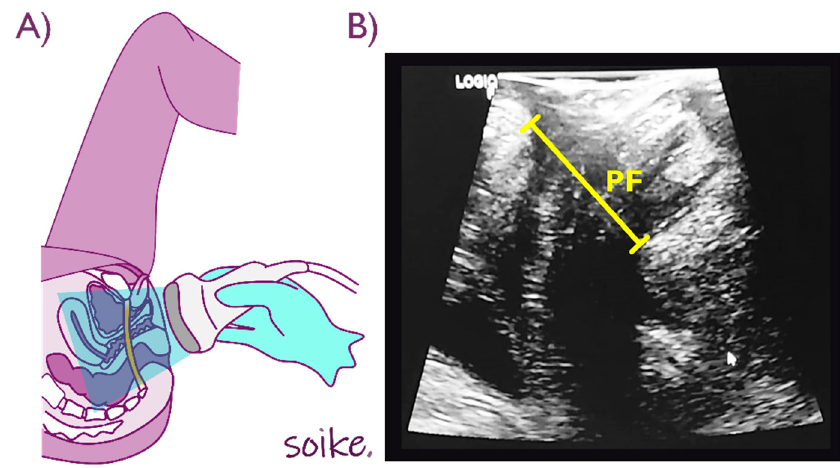
Figure 3. ( A ) Probe positioning, ( B ) pelvic floor (PF) muscle imaging. Source: Elena Castellanos López (AKA Soike).